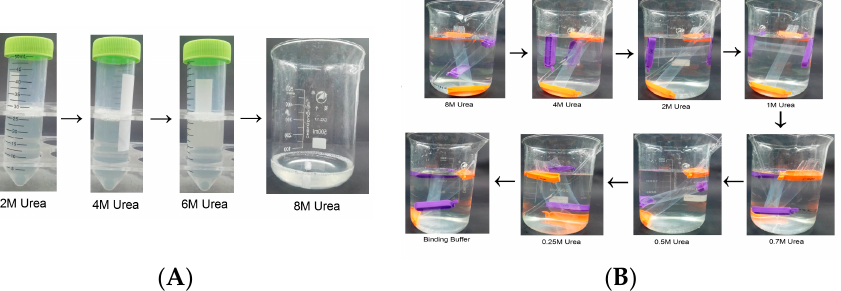
Figure 6. ( A ) Image of the denaturation process. 1: Inclusion body dissolved 3 times in 2 M urea. 2: Inclusion body dissolved 2 times in 4 M urea. 3: Inclusion body dissolved once in 6 M urea. 4: Inclusion body dissolved in 8 M urea was placed in a refrigerator at 4 ◦ C overnight. ( B ) Image of the renaturation process. Renaturation buffer (4–0.5 M urea, 0.5 M NaCl, 10 mM Tris, 0.5 mM ethylenediaminetetraacetic acid(EDTA), 1 mM L-arginine, 1 mM reduced L-glutathione, 0.2 mM oxidized L-glutathione, and 5 mM DL-Dithiothreitol (DTT), pH 8.5) was gradually added in a series of four dilutions and slowly stirred until the concentration of urea reached 0.25 M. The protein solution was transferred to a dialysis bag and incubated overnight at 4 ◦ C in dialysis buffer. During dialysis, the concentration was reduced, and binding buffer (20 mM Tris-base, 500 mM NaCl, and 20 mM imidazole) was used as the final dialysis